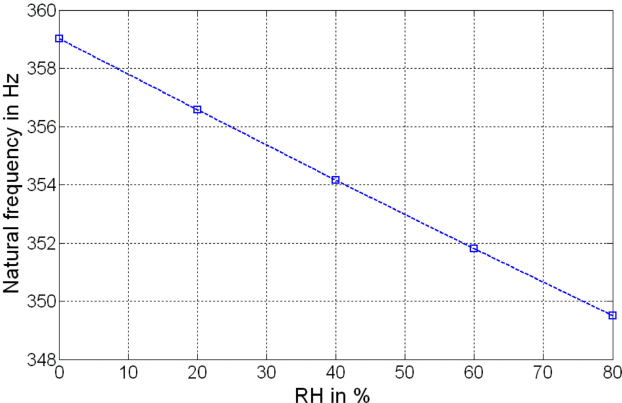
Figure 5. Simulated result: natural frequency as function of the relative humidity